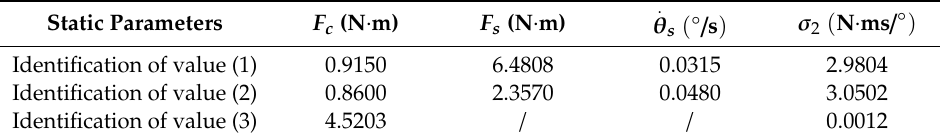
Table 1. Static parameters of the LuGre friction